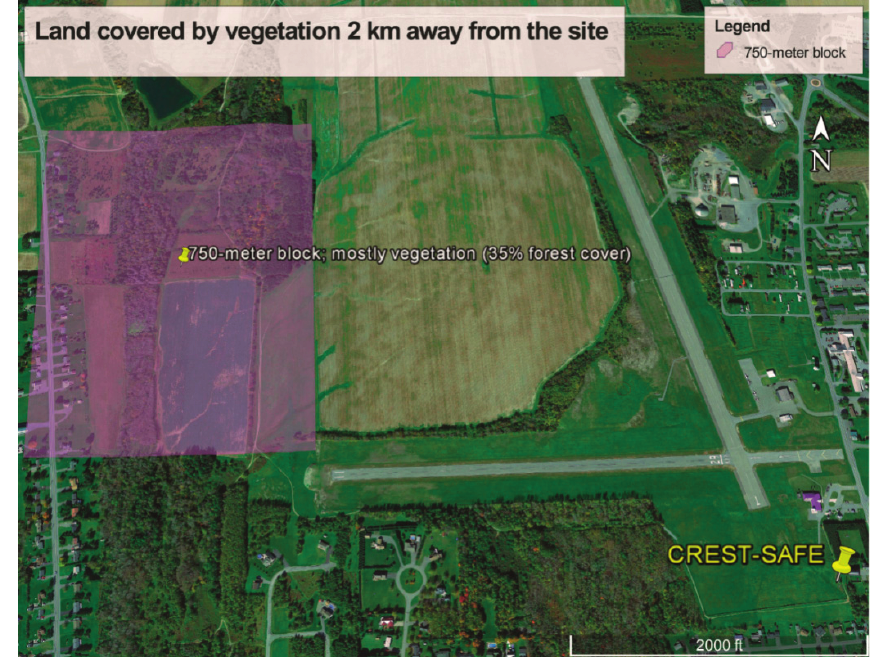
Figure 8 . 750 m block of land covered by forest and vegetation 2 km away from